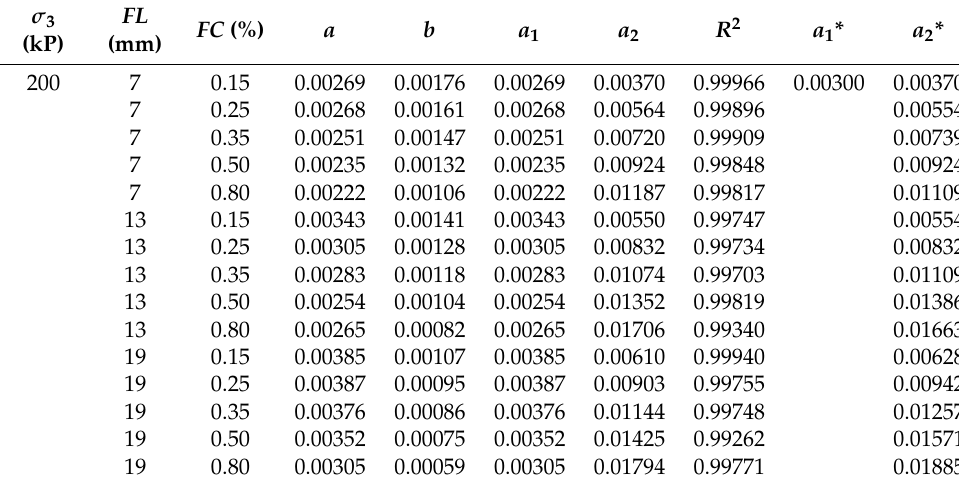
Table 5. Model parameters under 200 kPa cell